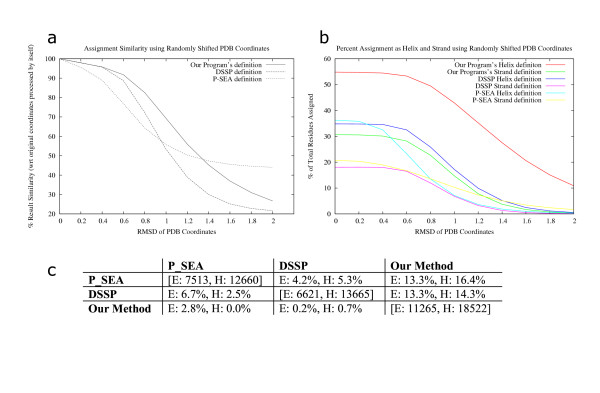
Secondary structure assignment reliability for DSSP, P-SEA and our program using randomly shifted PDB coordinates. The culled PDB set (described in methods) was used for this calculation. Gaussian random numbers were used to randomly shift coordinates of residues from 0.2Å to 2Å in steps of 0.2Å, in the PDB files. 100 files were generated for every file for every data-point leading to a total of 1,00,000 randomly shifted coordinate files. 2a: Mean and standard error of assignment consistency compared with assignment by the same program on the original coordinates. A percentage match was calculated by comparing definitions for the coordinate shifted file with the program output from actual file on a per residue basis. Means for the percentage match are shown. Standard errors were about 1% in each case (not shown). 2b: Average secondary structure content defined by each program for PDB files at different levels of perturbations are shown. The files used are the same as for fig. 8a. The number of residues assigned as helices or β-strands are shown as a percentage of total residues. Spaces and coils in the program output are counted for calculating percentages. 2c: Percentage of residues over-predicted by each program (DSSP, P-SEA, our method) with respect to the other two is shown. 100 files from the culled PDB set were used for these calculations. 35,670 residues were considered. Results shown are for over-predictions by program names in the column heads when compared with program names in the row heads. Actual number of helices and β-strands assigned by the program are shown on the diagonal (bracketed values).